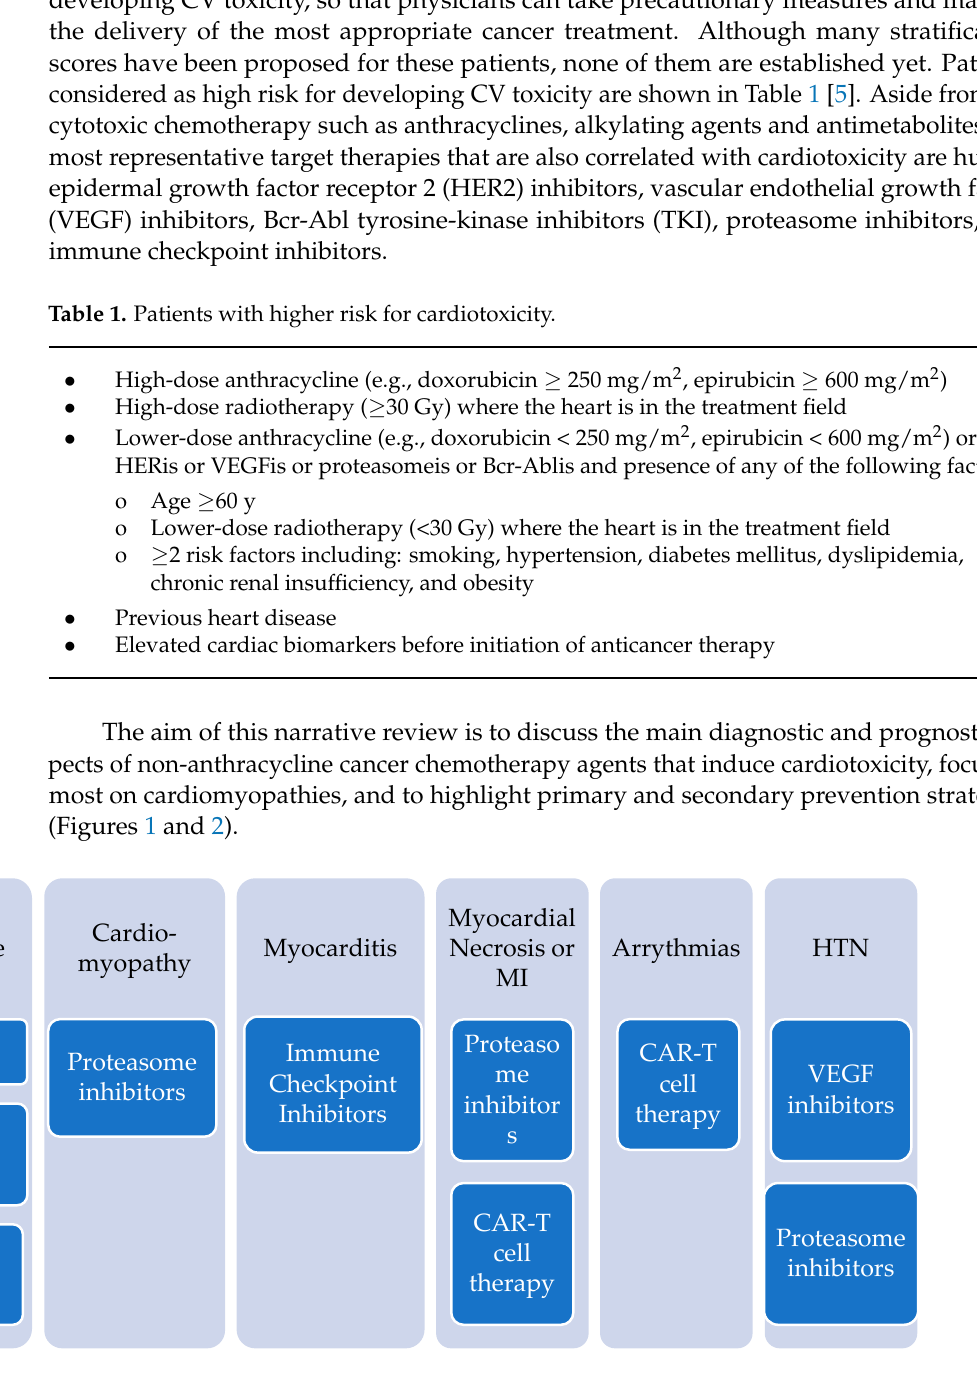
Figure 1. Most common manifestations of cardiotoxicity caused by non-anthracycline agents and the classes most often associated with them/that are implicated the most.